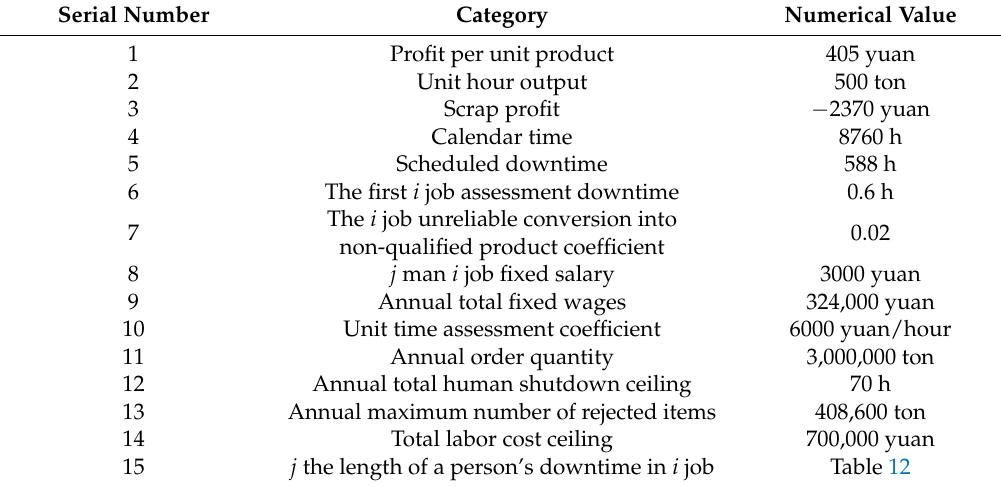
Table 11. Production data of the safety operators in an iron and steel